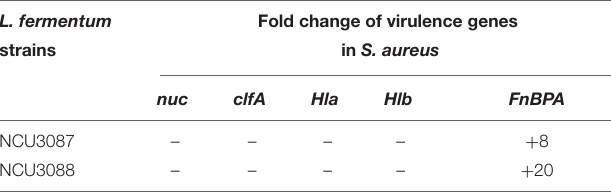
TABLE 3 | Fold change of virulence genes in S. aureus regulated by L. fermentum strains via RT-qPCR assay. L.